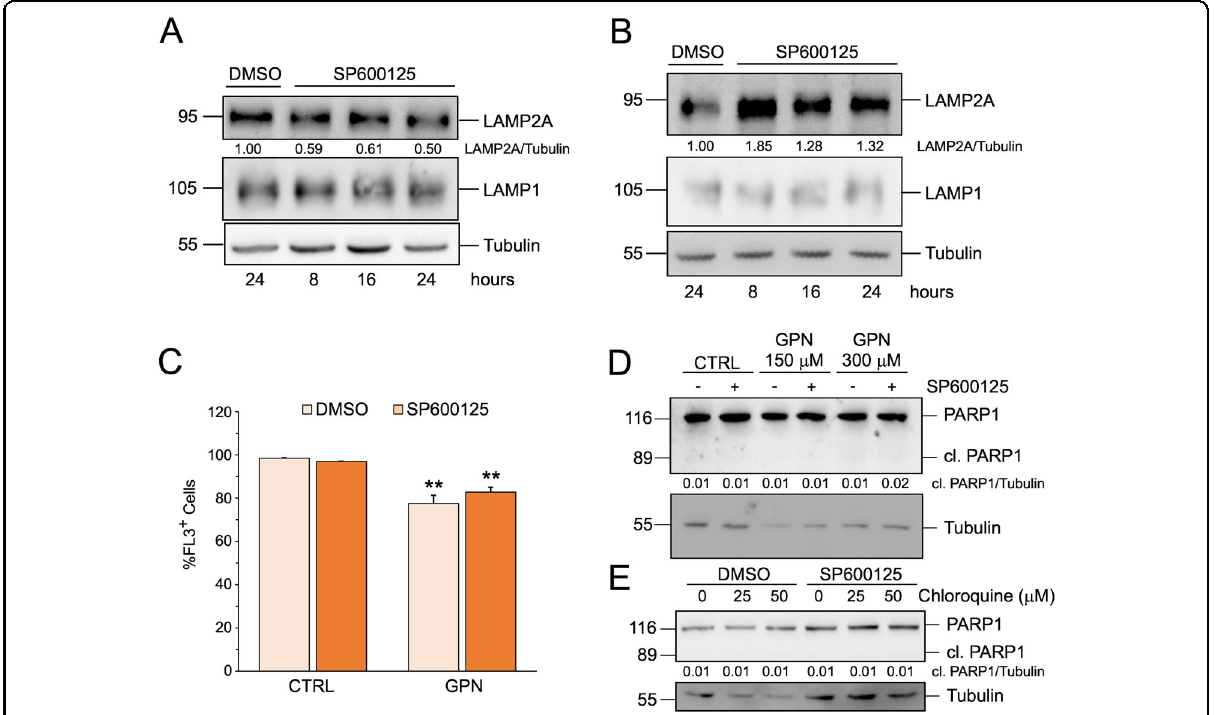
Fig. 3 JNK regulation of LAMP2A is cancer-cell speci fi c. A and B Western blot analyses of LAMP2A and LAMP1 expression in HepG2 ( A ) and HuS ( B ) cells treated with 10 μ M SP600125 for the indicated times. C Cyto fl uorometric analysis of intracellular acidi fi cation using acridine orange in HuS cells pre-treated for 6 h with 10 μ M SP600125 and then treated with 300 μ M GPN for an additional 2 h. Data are expressed as mean ± SEM of n = 3 independent experiments. ** p < 0.01 vs. CTRL. D and E Western blot analysis of PARP1 in HuS cells treated for 24 h with the indicated concentration of the lysosomotropic agents GPN ( D ) and chloroquine ( E ) in the presence or absence of 10 μ M SP600125. Where applicable, tubulin was used as a loading control. Western blots are representative of n = 3 independent experiments showing similar